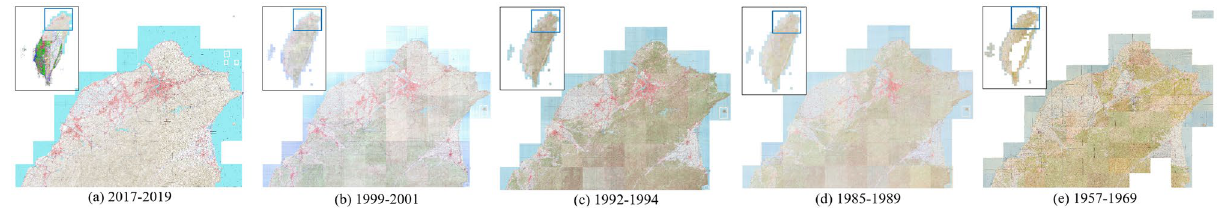
Figure 4. 1:25,000 Topographic maps of the northern Taiwan in 2017-2019, 1999-2001, 1992-1994, 1985-1989, and 1957-1969 from the GIS Center of Academia Sinica. The symbol styles of land use such as paddy fields, orchards, grasslands and unused land have been adjusted due to cartographic regulations changes between releases. The same legend was used in the late 20th century (versions b to d) probably for easing the translations between these maps. Refer to the digital version of this paper for detailed zoom-in with full resolution. † The maps in this figure are provided by Taiwan Historical Maps System (https:// gis. sinica. edu. tw/ tiles erver/) with permission.